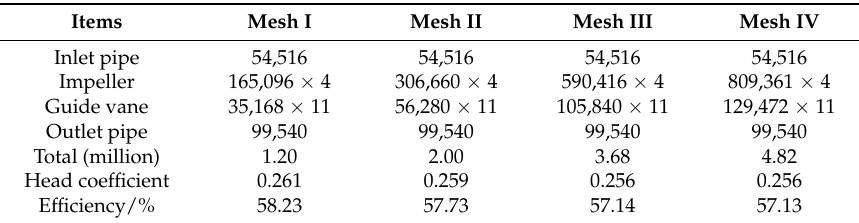
Table 3. Mesh independence analysis.